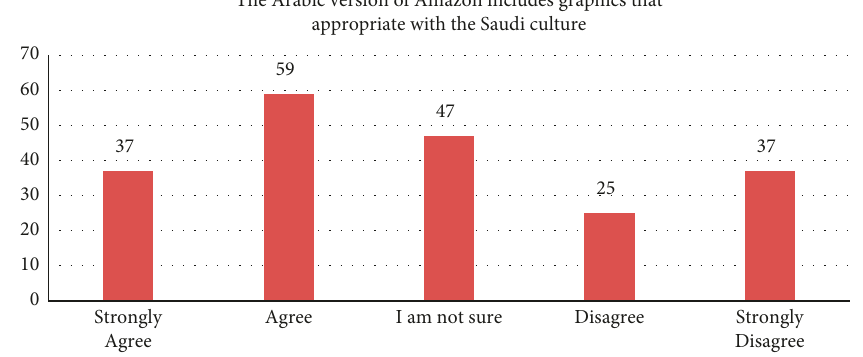
Figure 10: Participants’ responses regarding the cultural appropriateness of the pictorial content of